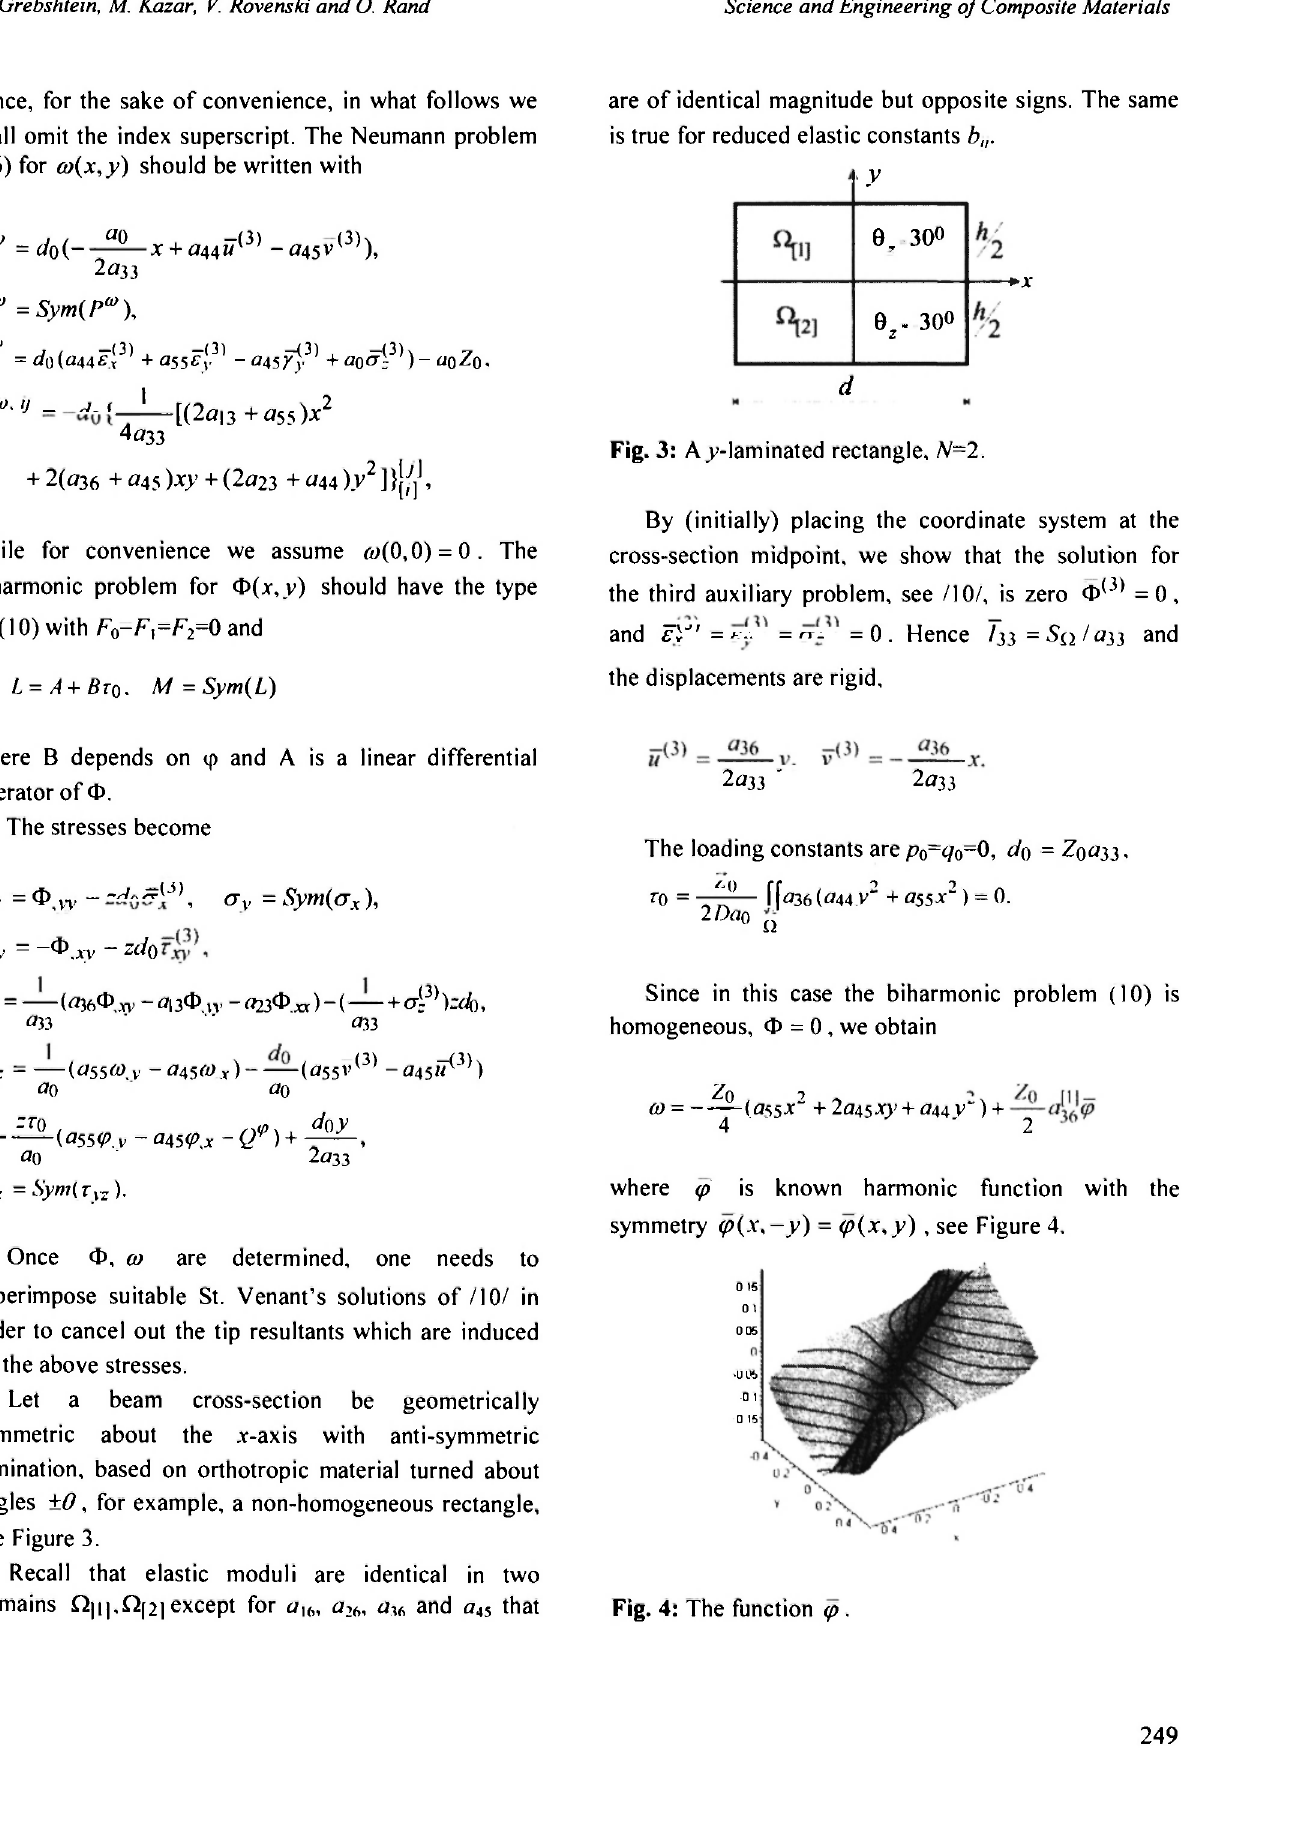
Fig. 3: A ^-laminated rectangle, N=2.